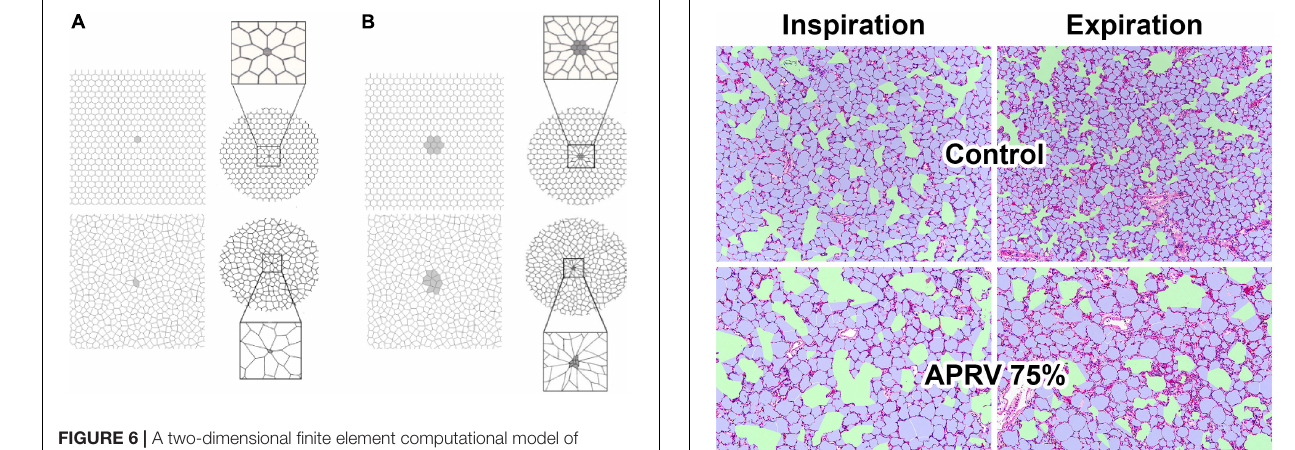
FIGURE 6 | A two-dimensional finite element computational model of interconnected alveolar walls to study the impact of areas of stress-focus (S-F) on stress–strain relationships. Both a hexagonal honeycomb (top) and Voroni honeycombs (bottom) were studied with areas of S-F created by increasing the stiff regions in one (A) or nine (B) cells. These stiff regions simulate collapsed alveoli adjacent to open alveoli that create an S-F in acute respiratory distress syndrome (ARDS) patients ( Figure 4 ) (Cressoni et al., 2014). The entire honeycomb structure was expanded and exposed to strains of 15, 30, 45, and 55% above the resting geometry. Some of the alveolar walls in the Voroni honeycomb were exposed to a S-F ∼ 16 times greater than that applied to uniformly expanded areas. This suggests that ventilation pressures considered safe in ARDS patients ( < 30 cm H 2 O) (Acute Respiratory Distress Syndrome Network, 2000) could be causing local stress concentration on some alveolar walls of approximately 48 cm H 2 O, with even higher stress in areas of S-F (Makiyama et al., 2014). Permissions obtained from Elsevier. License 4699410294890.